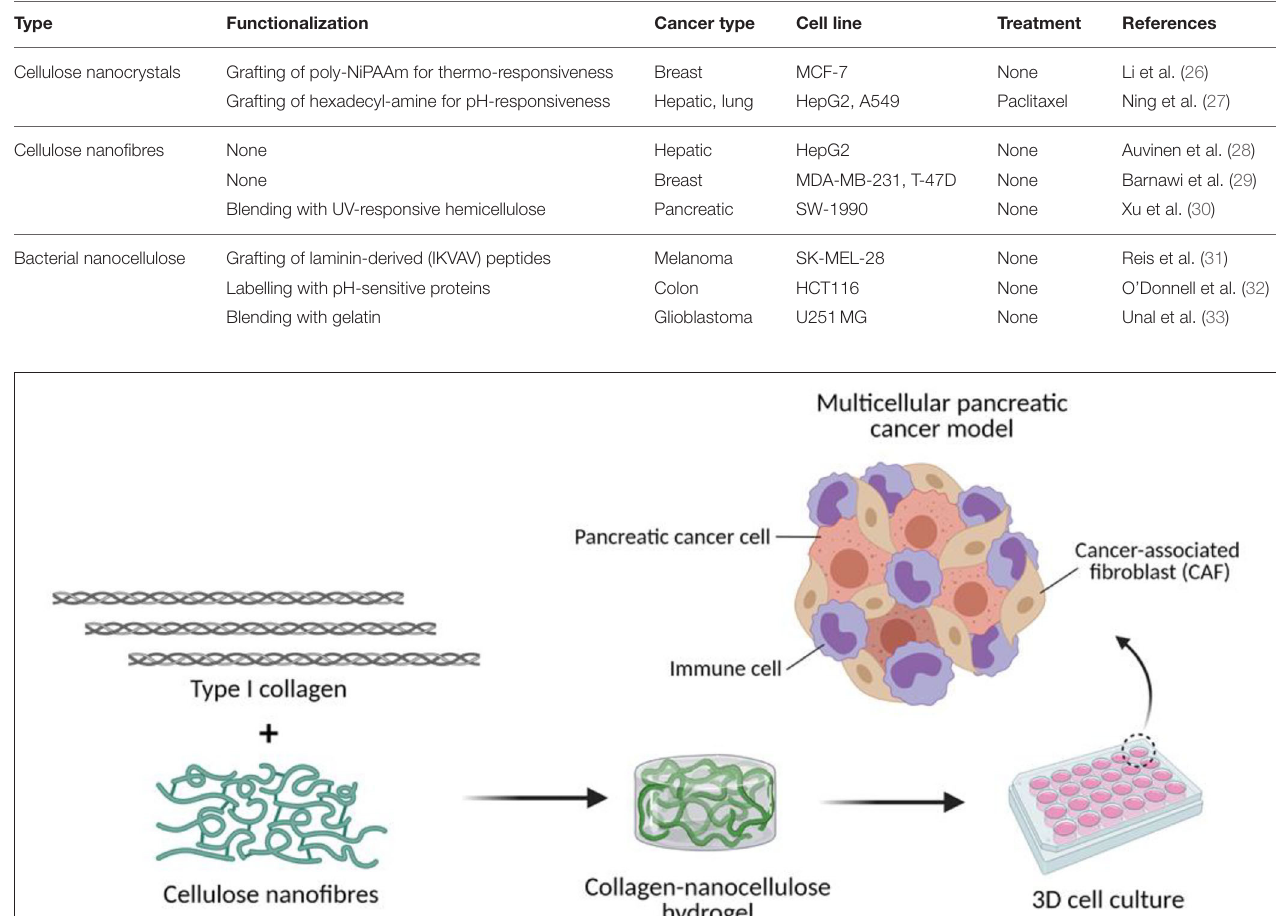
TABLE 1 | Examples of cellulose hydrogels applied as 3D cancer models.